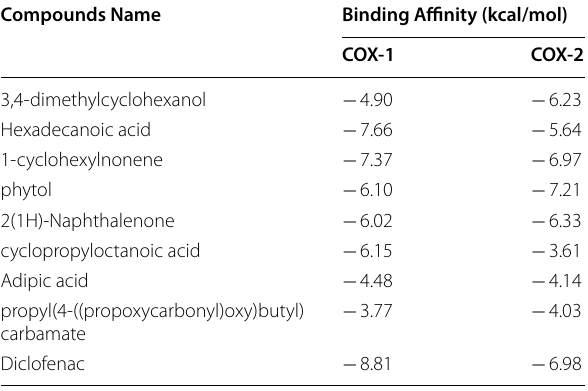
MW molecular weight (< 500), HBA number of hydrogen bond acceptors (< 10), HBD number of hydrogen bond donor (< 5), XlogP the partition coefficient topological polar surface area Table 4 Docking score of